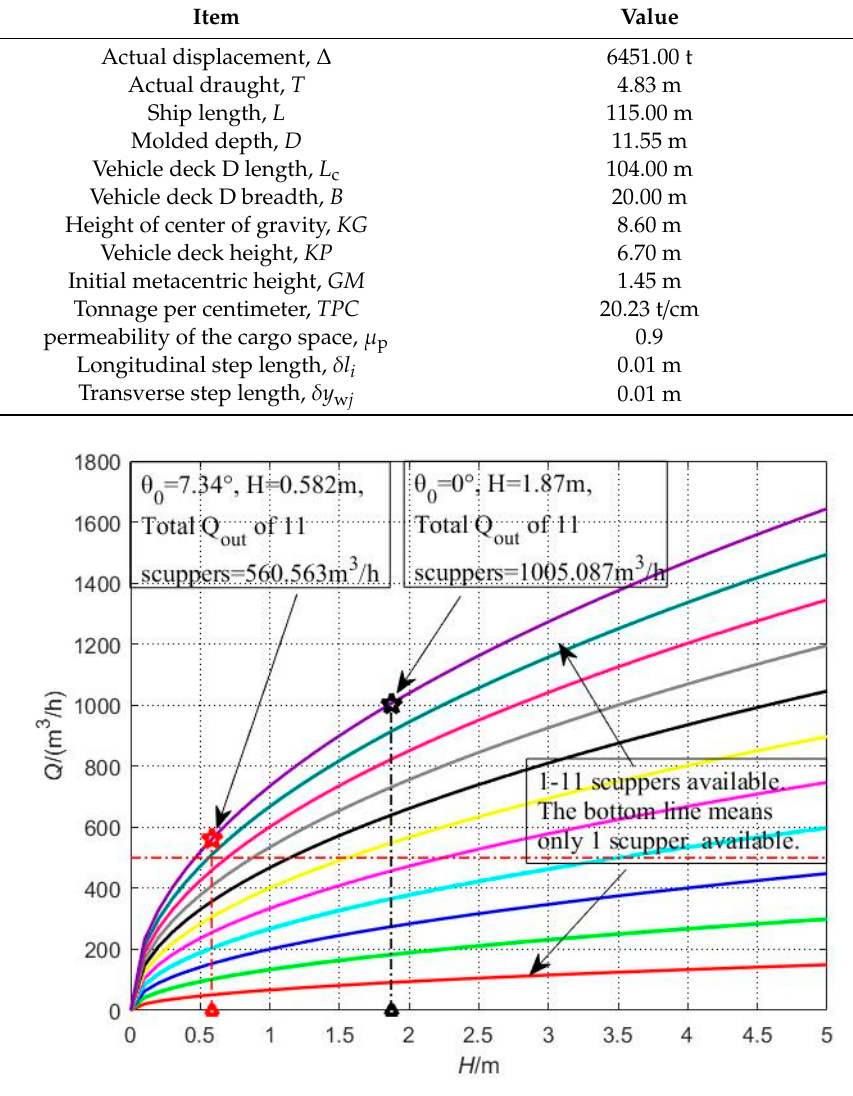
Figure 6. Scupper discharge capacity of vehicle deck D.